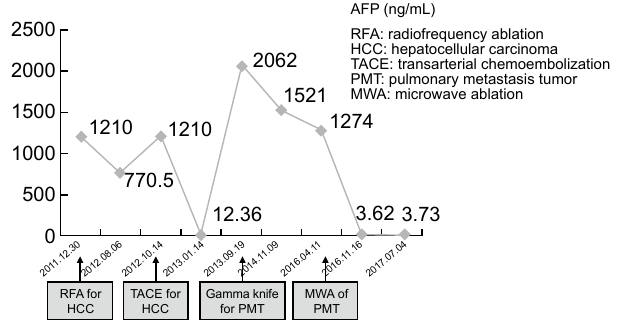
AFP (ng/mL) RFA: radiofrequency ablation HCC: hepatocellular carcinoma TACE: transarterial chemoembolization